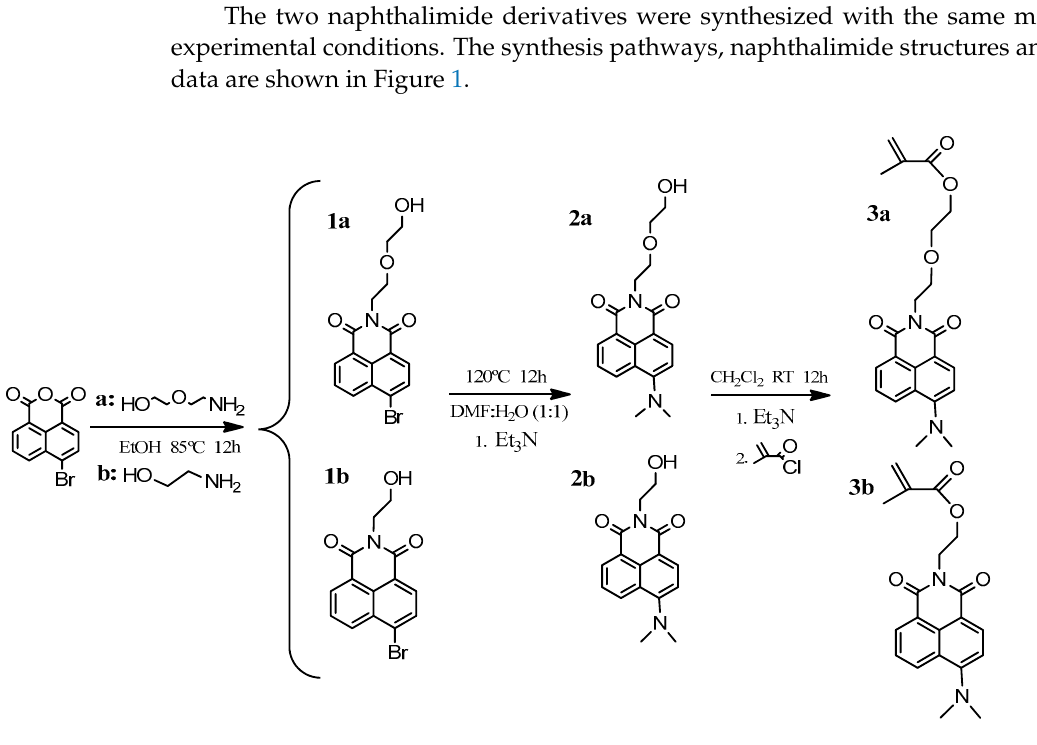
Figure 1. Synthesis of the naphthalimide derivatives.